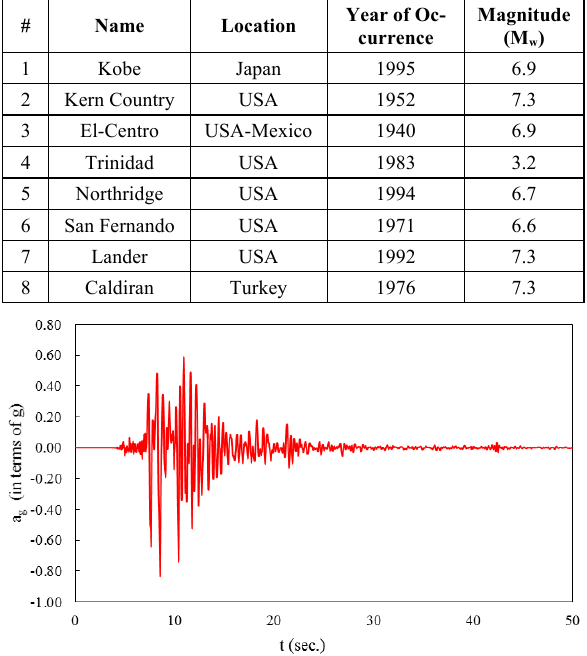
Figure 4. Kobe Earthquake time